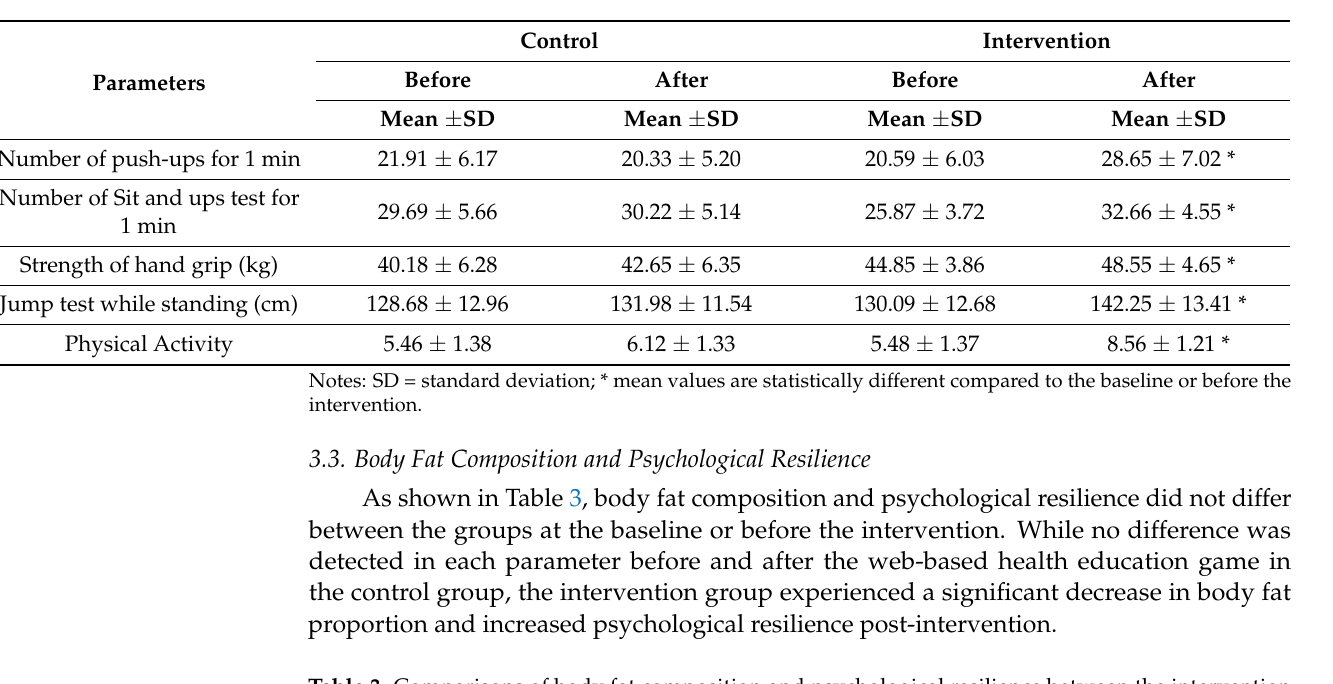
Table 2. Comparisons of overall physical activity and specific exercises performed in the intervention and control groups.